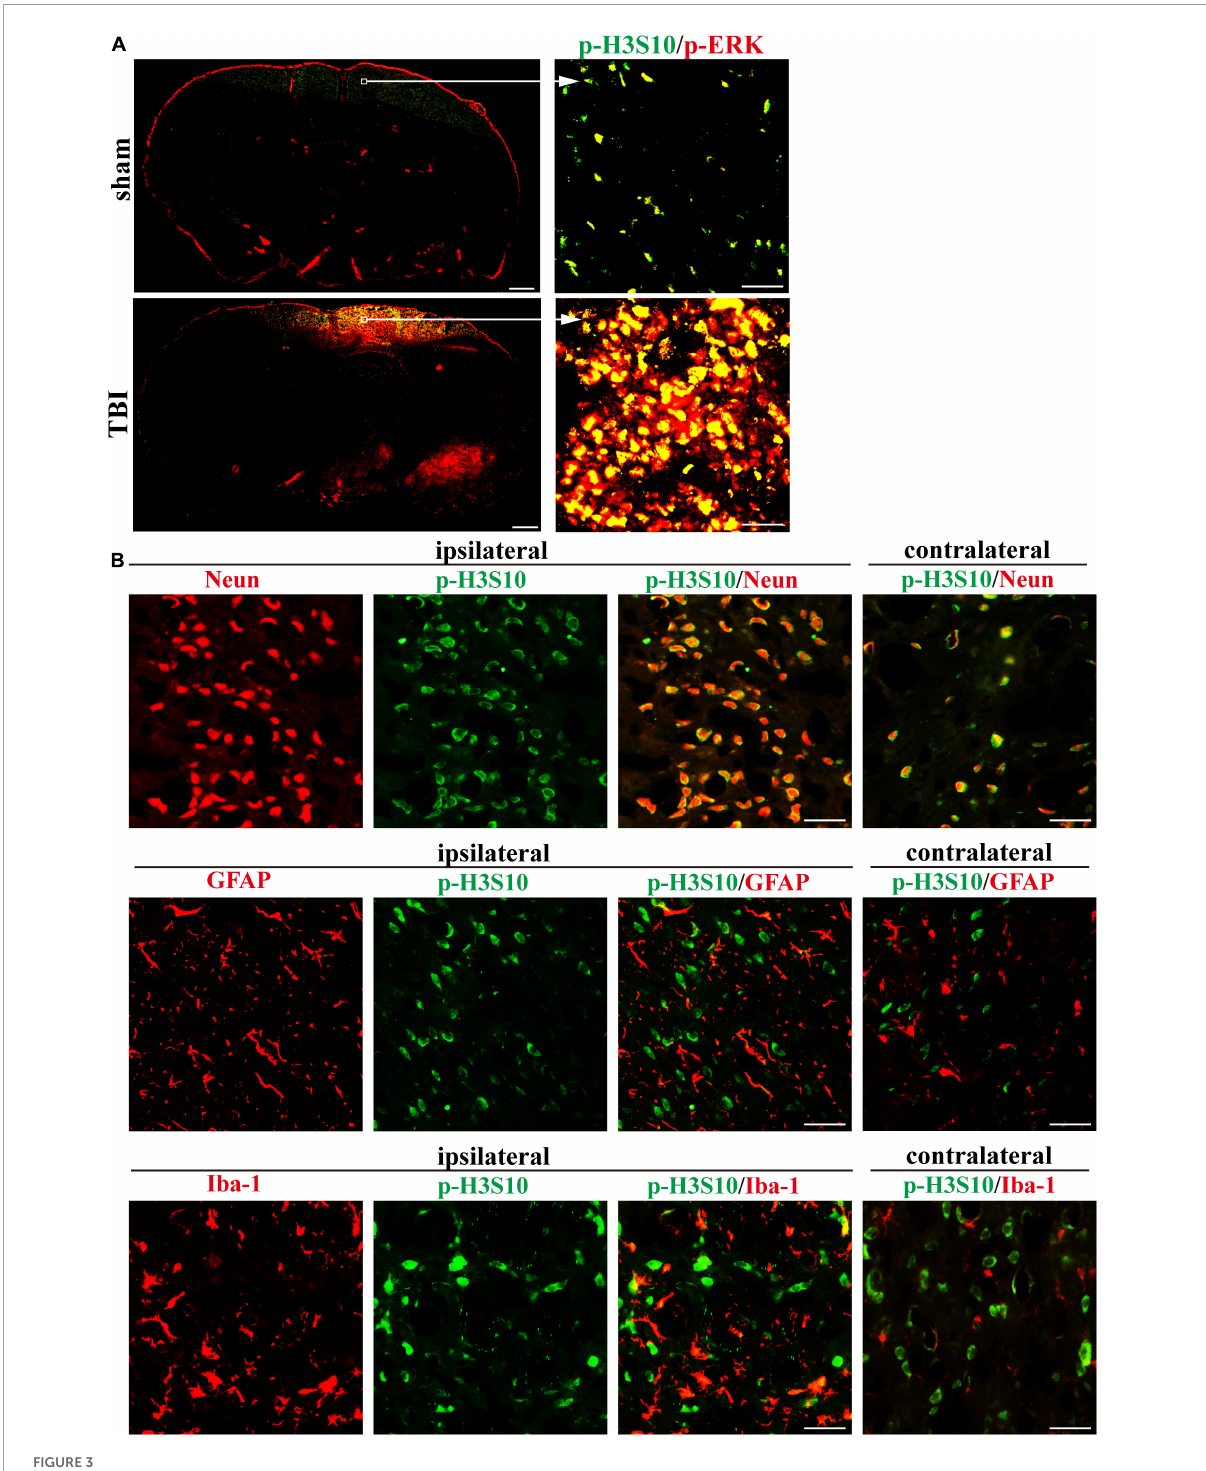
FIGURE3 Immunofluorescence in rat brain sections shows high levels of p-H3S10 and p-ERK in the cortex adjacent to the TBI site and their colocalization on the seventh day after TBI. (A) Both p-H3S10 and p-ERK were highly expressed in the region near the injury site compared with their levels on the uninjured side. p-H3S10 and p-ERK were colocalized and upregulated in the TBI rats compared with the sham rats. Scale bar = 1000 µ m (left) and 50 µ m (right), respectively. (B) p-H3S10 was colocalized with NeuN (neuron marker), GFAP (astrocyte marker) and Iba-1 (microglia marker) in the TBI rats. Scale bar = 50 µ